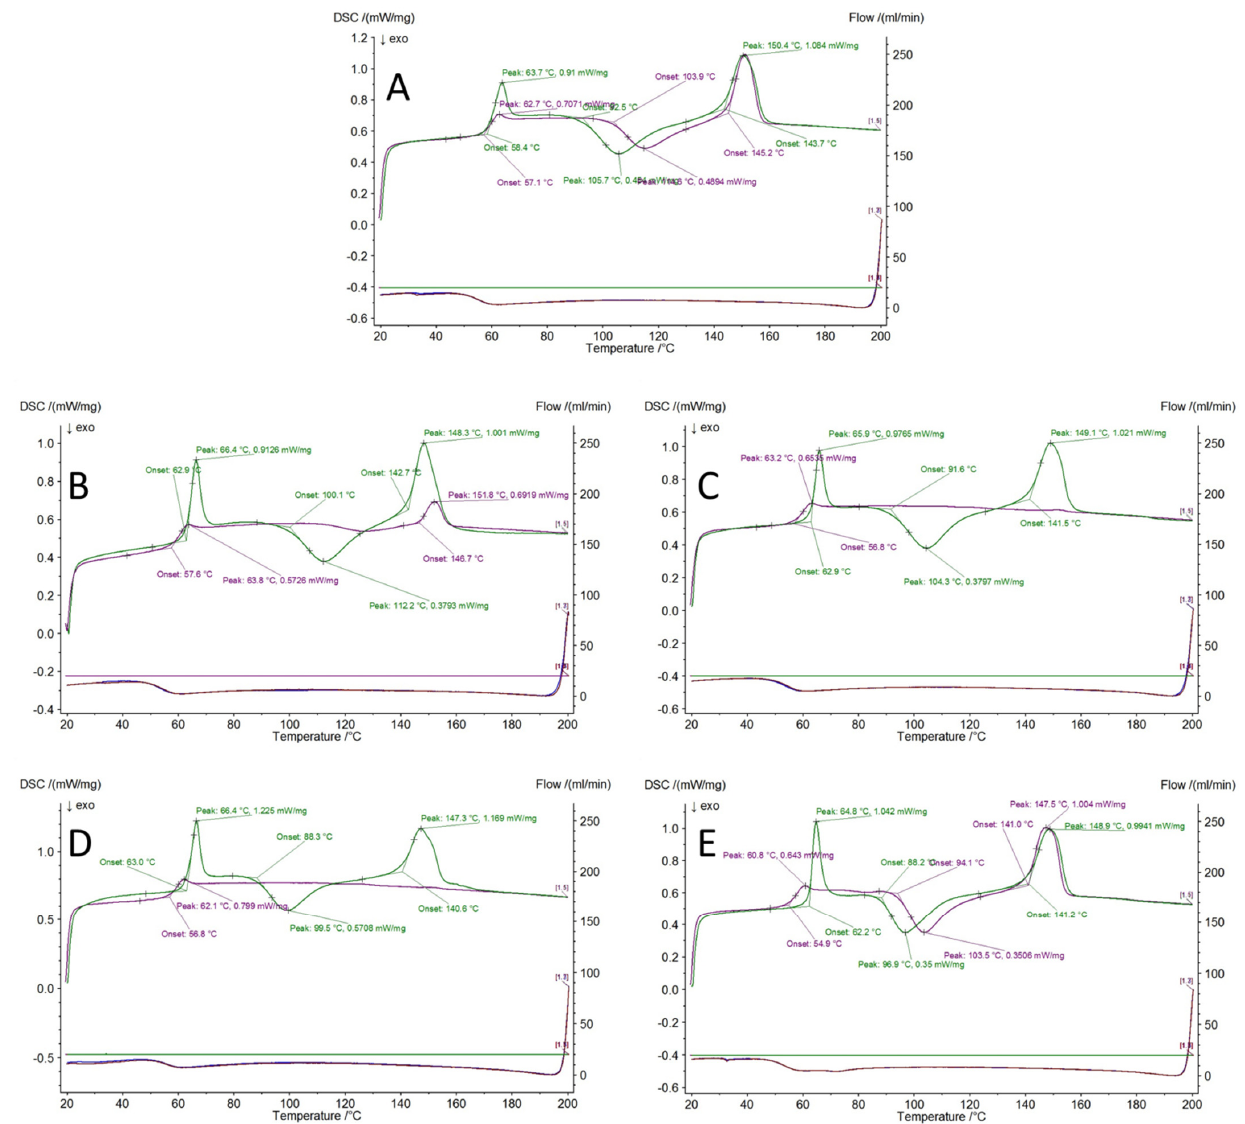
Figure 6. DSC curves of the first (green line) and second (violet line) heating of the electrospun membrane materials; ( A ) Neat PLA membrane; ( B ) PLA/SS-Limonene; ( C ) PLA/iBu 7 SSQ-3OH; ( D ) PLA/iBu 7 SSQ-OEt; ( E ) PLA/SSQ-8Cl.